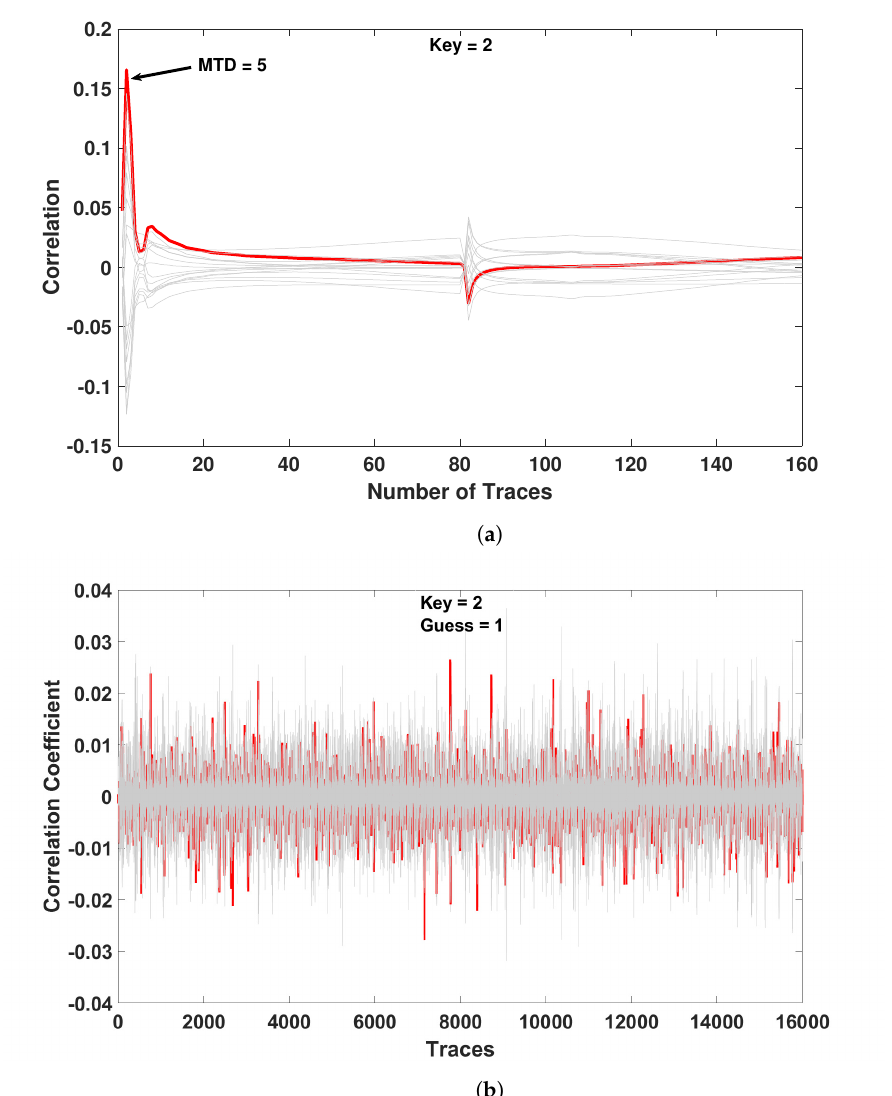
Figure 17. Correlation power analysis performed on EE-ACML implementation of PRESENT-80. ( a ) Successful CPA attack on CMOS-based implementation of PRESENT S-box with key = 2. ( b ) Un- successful CPA attack on EE-ACML-based implementation of PRESENT S-box with key =